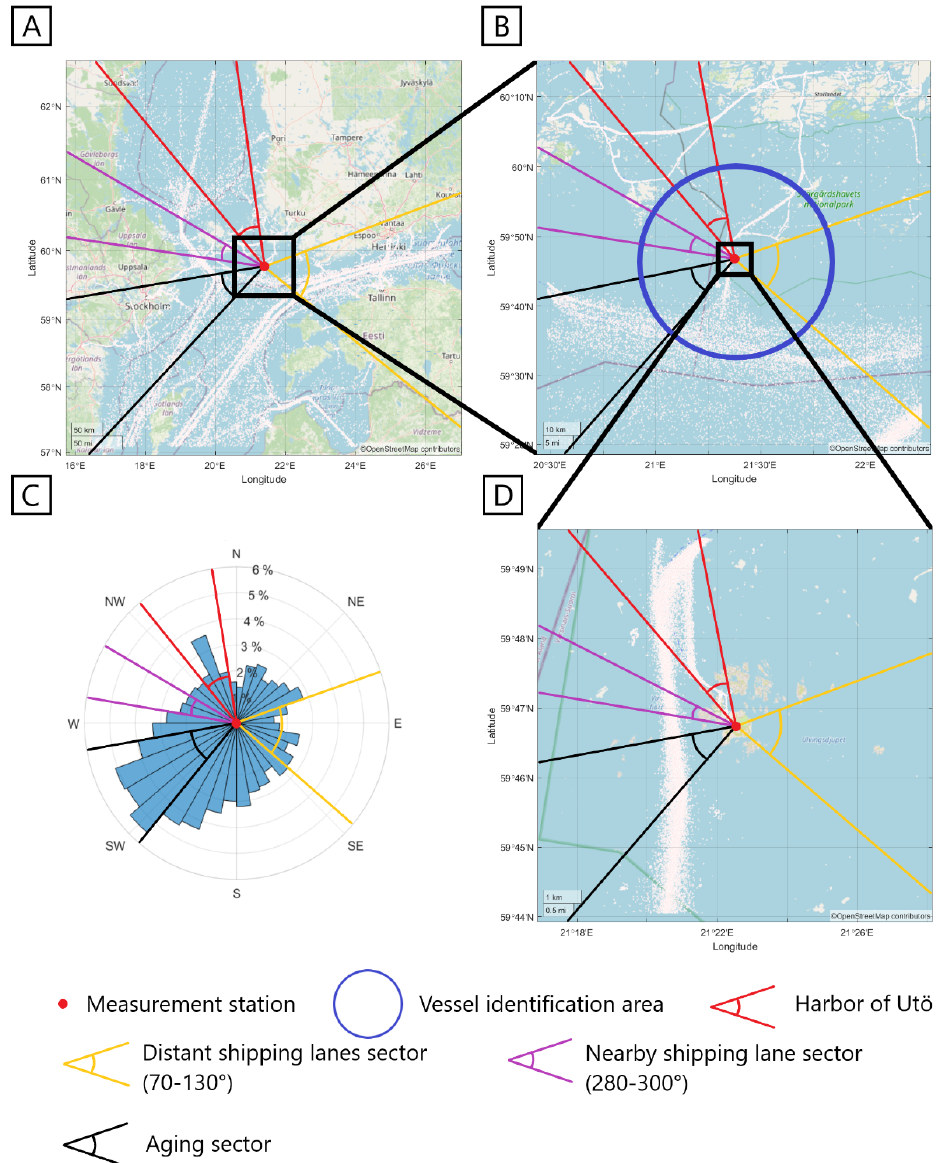
Figure 1. (a) The location of Utö island and the locations of vessels with International Maritime Organization (IMO) numbers in a 360000km 2 area around Utö. (b) The location of vessels with IMO numbers in a 10000km 2 area around Utö. (c) Percentage of the time that wind was blowing from different directions during valid measurement periods divided into 10 ◦ sectors. (d) The location of vessels with IMO numbers in a 100km 2 area around Utö. White dots in panels (a) , (b) , and (d) mark the locations of vessels (0.01%, 0.2%, and 10% of the locations plotted for panels (a) , (b) , and (d) , respectively). The distant shipping lanes sector, aging sector, nearby shipping lane sector, and harbor of Utö are marked with colored lines. Base map and data from OpenStreetMap and OpenStreetMap Foundation (OSMF).